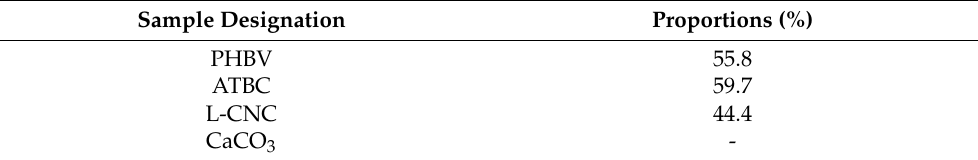
Table 2. The individual proportions of total organic carbon of PHBV biocomposite